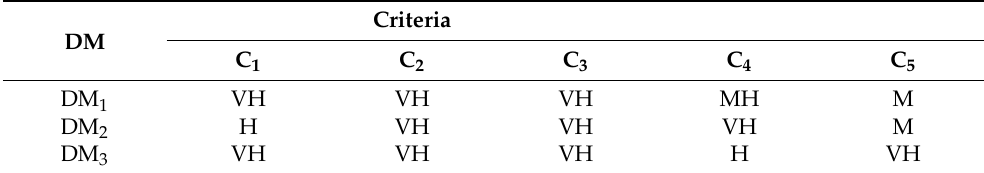
Table 15. Each criterion weight in linguistic term. DM